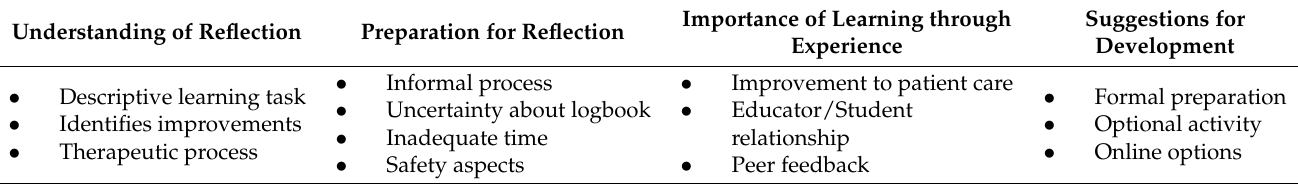
Table 2. Summary of